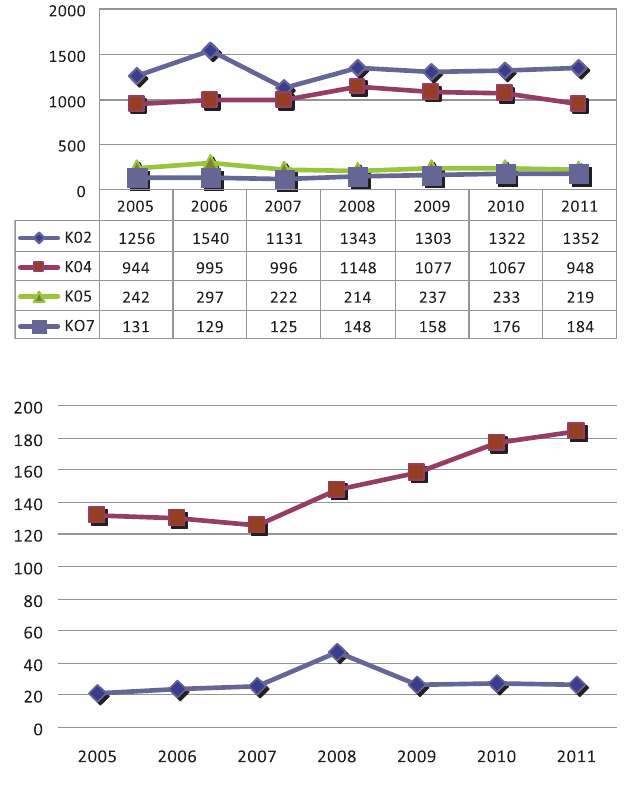
FIGURE 1. Number of dental caries (K02), diseases of pulp and periapical tissues (K04), gingivitis and periodontal diseases (K05) and dentofacial anomalies (K07) per 10.000 popula- tions, recorded in time period from year 2005 to 2011. Diseases diagnosed as dental caries (K02), other diseases of hard tissues of teeth (K03), diseases of pulp and periapical tissues (K04) and gingivitis and periodontal diseases (K05) per 10.000 populations showed a little variation compared to the observed time